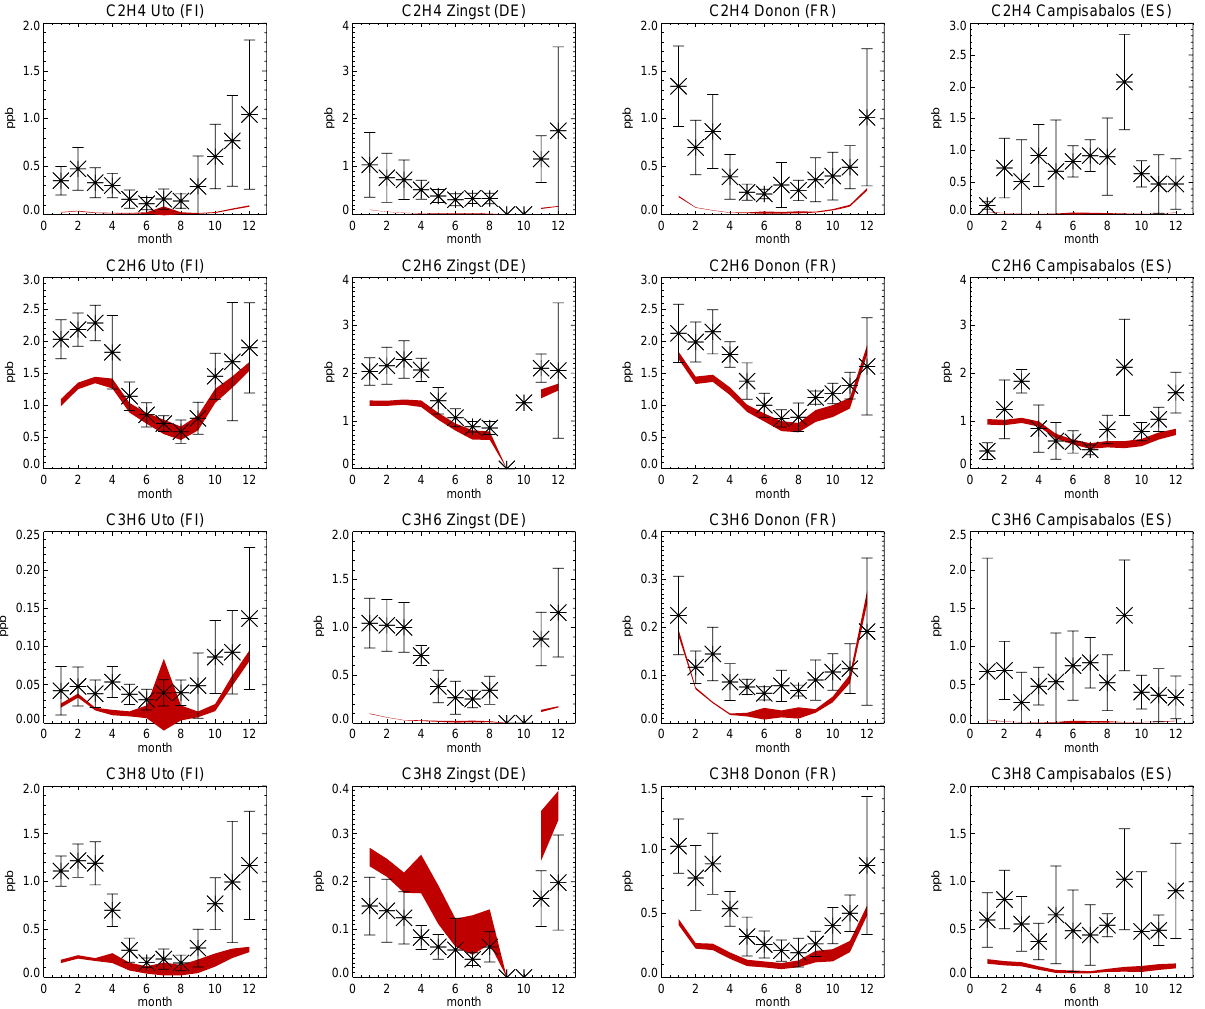
Fig. 6. The seasonal variability in selected C2 and C3 alkanes and alkenes sampled at various EMEP monitoring stations during 2000. Comparisons are shown for (from top row downwards) C 2 H 4 , C 2 H 6 , C 3 H 6 and C 3 H 8 , respectively, for single stations located at Ut¨o (Finland, 59.5 ◦ N, 21.1 ◦ E), Zingst (Germany, 54.4 ◦ N, 12.7 ◦ E), Donon (France, 48.3 ◦ N, 7.8 ◦ E) and Campisabalos (Spain, 41.1 ◦ N, 3.8 ◦